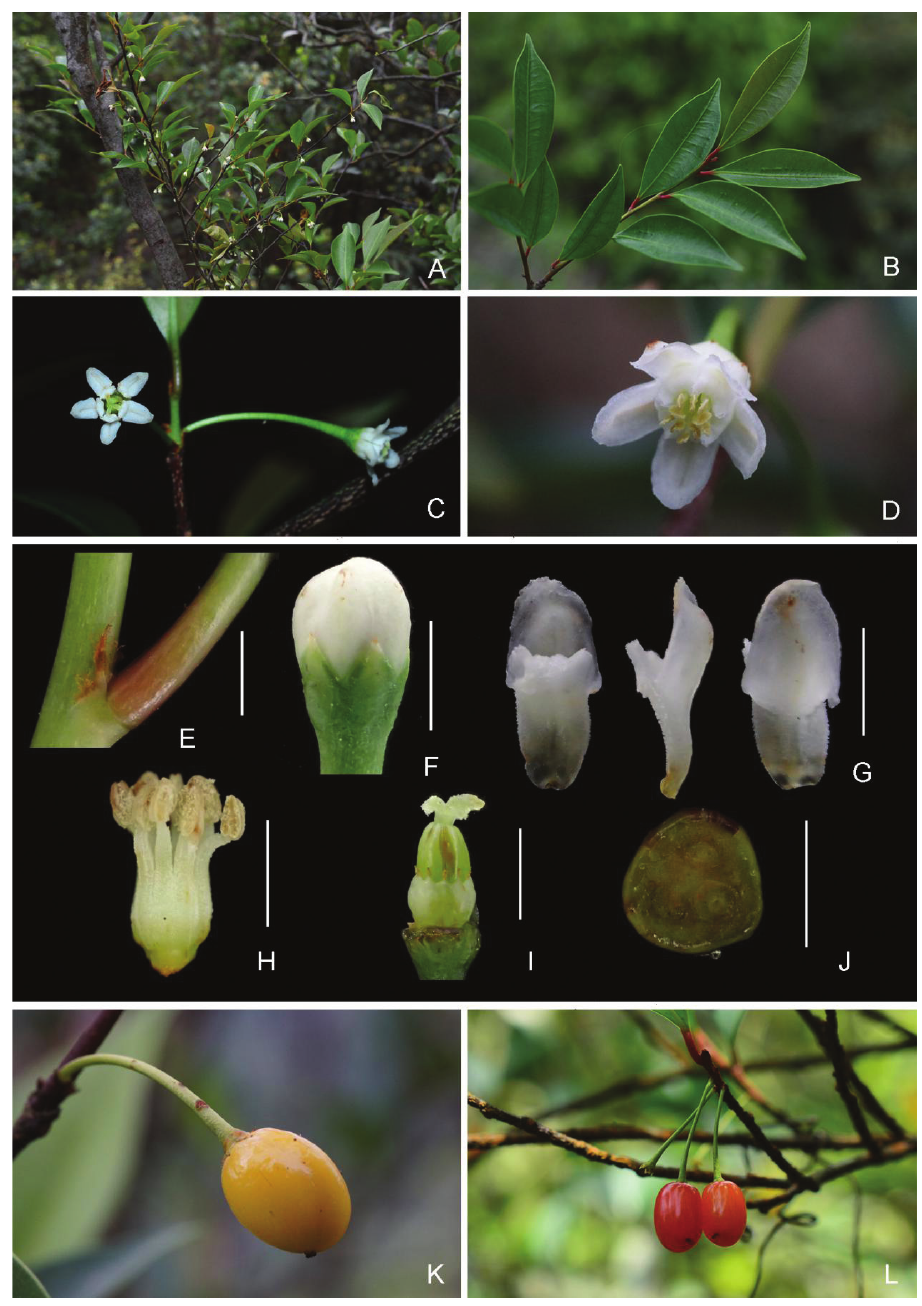
Figure 1. Erythroxylum austroguangdongense A flowering branches B leafy branches C female flowers D male flower E stipule, showing fimbriate margin F flower bud, showing calyx G petals, adaxial (left), lateral (middle) and abaxial (right) view H androecium I staminodes and pistil J cross section of ovary, showing one fertile locule (low right) K–L fruits. Scale bars: 3 mm ( H ); 2 mm ( E–G, I ); 1 mm ( J ). Pho- tographs A–B by Xin-Xin Zhou D, K by Wei-Jun Chen H by Xue-He Ye and others by Chun-Mei